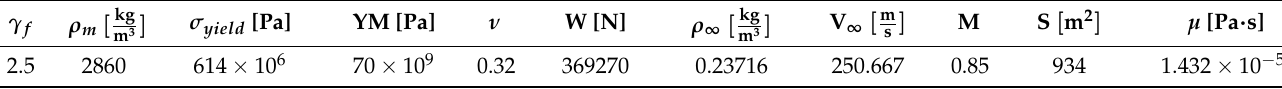
Table 1. Data and constraints for the optimization.